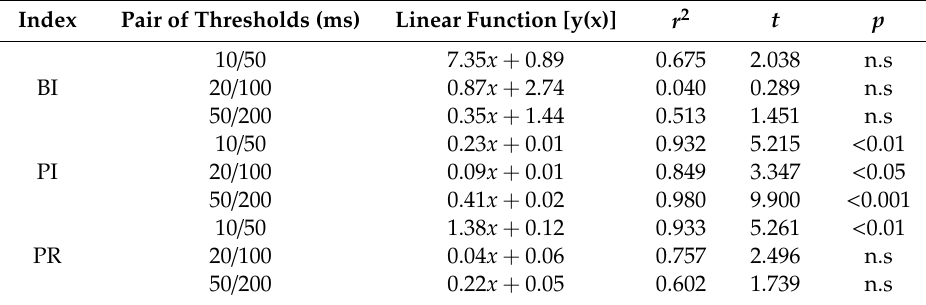
Table A2. Parameters for the double negative exponential functions fitted for pdf.